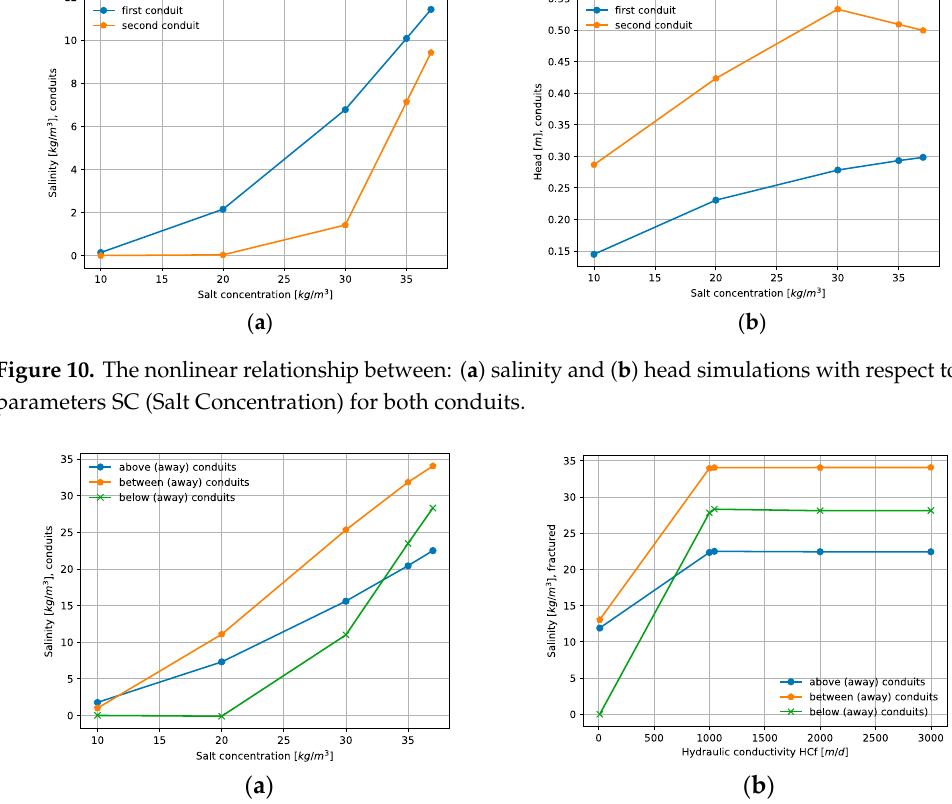
Figure 11. Nonlinear relationship between: ( a ) Salinity and salt concentration; ( b ) Salinity and HDf both in the fractured medium away from the conduits using the locations where the Css are maximum.